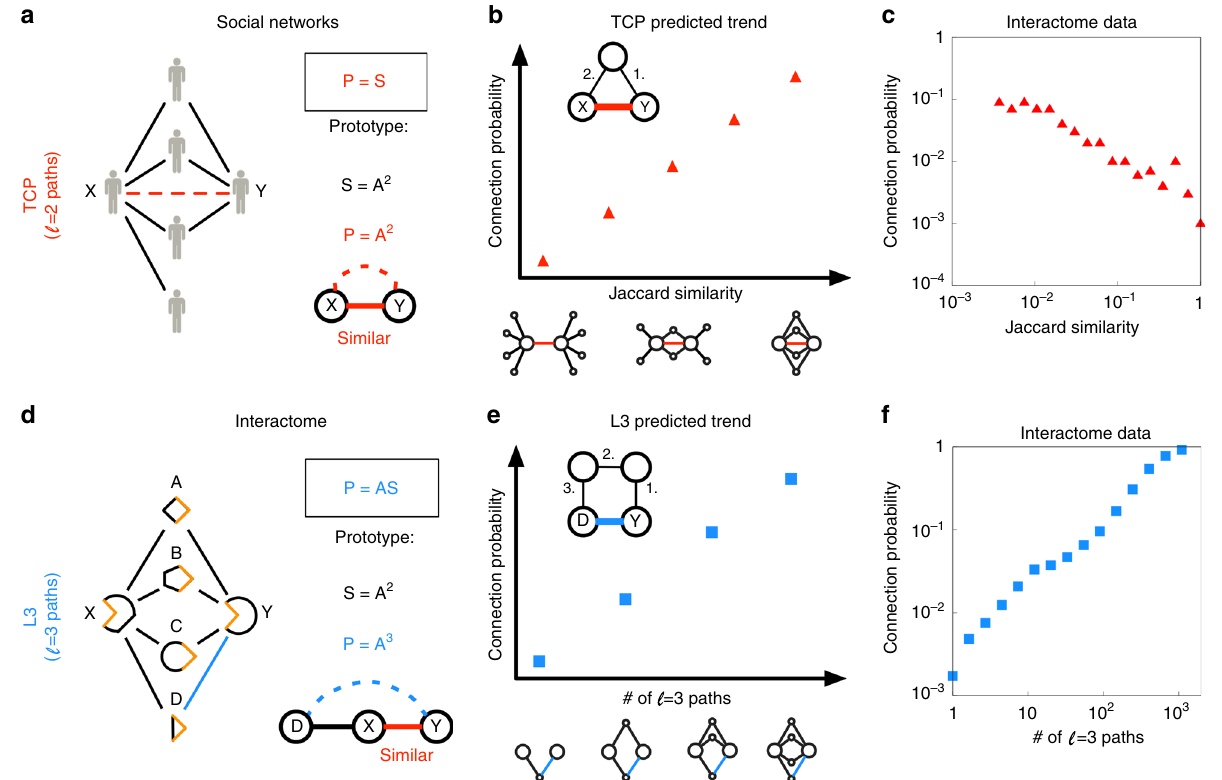
Fig. 1 Network similarity does not imply connectivity. a In social networks, a large number of common friends implies a higher chance to become friends (red link between nodes X and Y), known as the Triadic Closure Principle (TCP). TCP predicts ( P ) links based on node similarity ( S ), quantifying the number of shared neighbors between each node pair ( A 2 ). b A basic mathematical formulation of TCP implies that protein pairs of high Jaccard similarity are more likely to interact. c We do not observe the expected trend in Protein-Protein Interaction (PPI) datasets, as illustrated here for a binary human PPI network (HI-II-14) 5 : high Jaccard similarity indicates a lower chance for the proteins to interact (see Supplementary Fig. 3 for further networks). The data are binned logarithmically based on the Jaccard similarity values. d PPIs often require complementary interfaces 10,11 , hence, two proteins, X and Y, with similar interfaces share many of their neighbors. Yet, a shared interface does not typically guarantee that X and Y directly interact with each other (see Supplementary Fig. 1 for an illustration with known 3D structures). Instead, an additional interaction partner of X (protein D) might be also shared with protein Y (blue link). Such a link can be predicted by using paths of length 3 (L3). L3 identi fi es similar nodes to the known partners ( P = AS ), going one